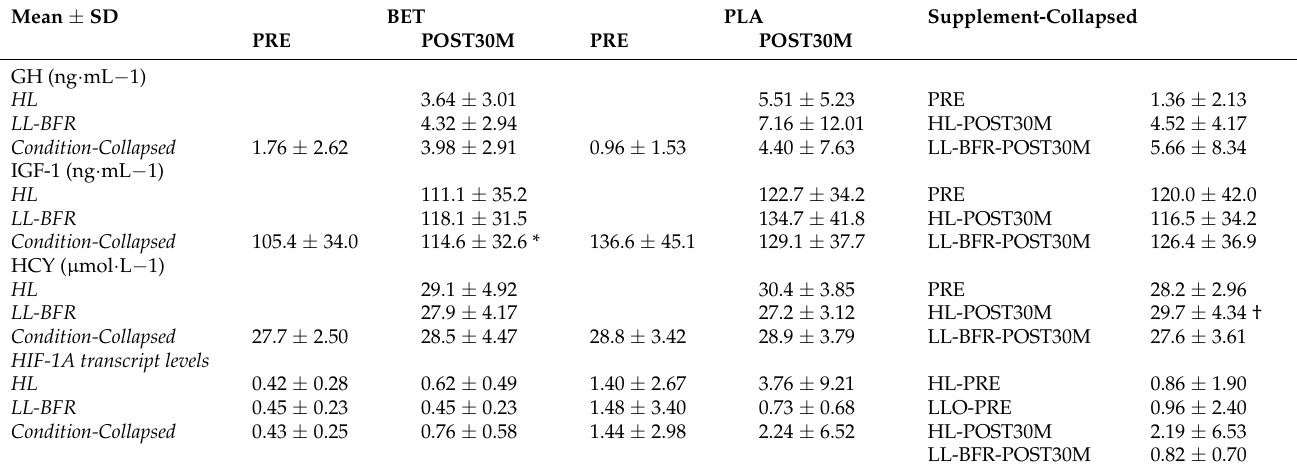
Table 5. Serum GH, IGF-1, and HCY concentrations, as well HIF-1A transcript levels across all condition and supplement combinations. All data are presented as means ± SD. * Condition-collapsed BET displayed significantly higher IGF-1 concentrations relative to PLA and † Supplement-collapsed HL-versus-LLO demonstrated significantly greater HCY concentrations ( p <